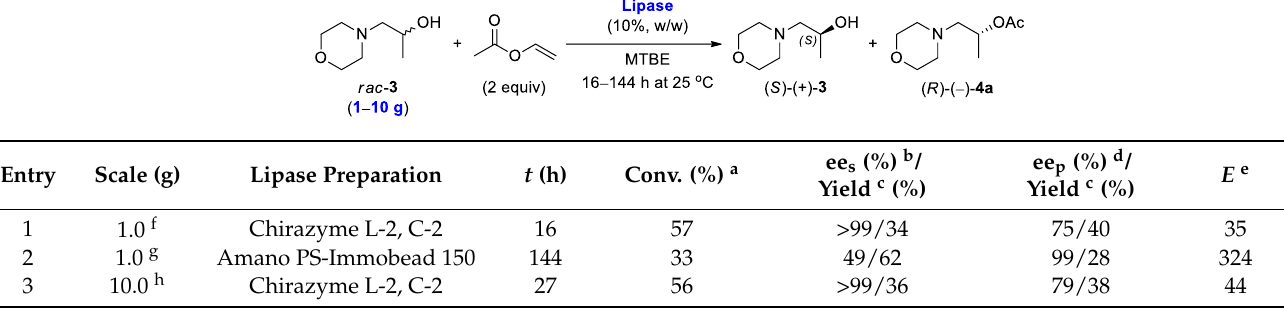
Table 4. Gram- and multigram-scale lipase-catalyzed enantioselective transesterification of rac - 3 .